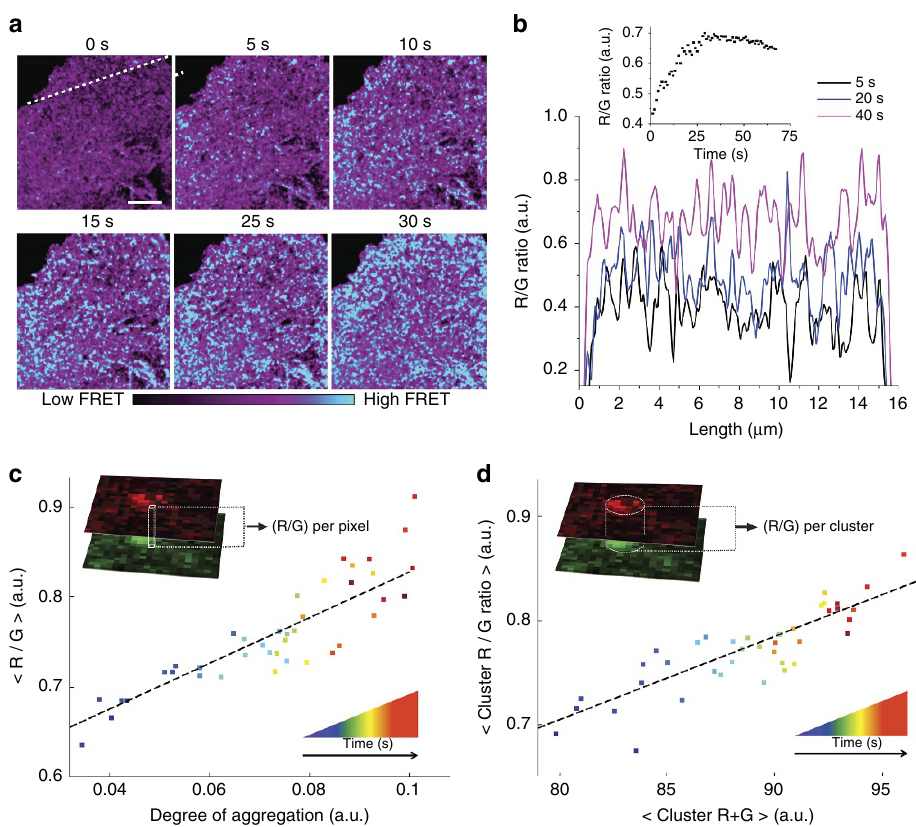
Figure 3 | Detection of light-induced CY2PHR clustering by CliF with image correlation spectroscopy (ICS) and particle tracking. ( a ) Donor/acceptor (R/G) ratiometric images of light-induced clustering of CY2PHR-CliF in transfected COS-7 cells at the indicated time points. Images are pseudocoloured from purple to blue corresponding to low and high FRET efficiency. Scale bar, 2 m m. ( b ) R/G values along line scans at positions shown in a at selected time points. Inset: R/G ratio of individual frames plotted as a function of time. ( c ) Image Correlation Spectroscopy (ICS) analysis of data shown in a . Scatter plot of R/G ratio against degree of aggregation for each frame. The amplitude of ICS was normalized to the total intensity (donor þ acceptor intensity, R þ G) for each frame yielding a value for the degree of aggregation ( x axis). It displayed a linear relationship (slope ¼ 2.52, R 2 ¼ 0.75) with CY2PHR-CliF FRETefficiency (R/G ratio, y axis). ( d ) Cluster tracking of data shown in a for each cluster, the R/G value (reflecting cluster density) was plotted against the R þ G value (reflecting number of molecules), resulting in a linear relationship (slope ¼ 0.008, with R 2 ¼ 0.72). Symbols are coloured in c , d according to the frame number during the time course. Data in b – d is single representative data of 5